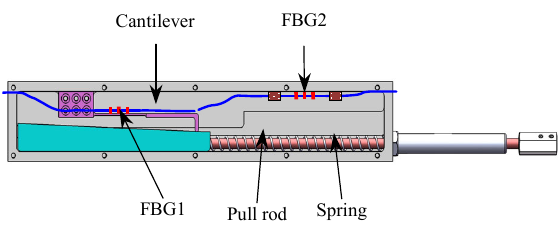
Fig. 6 Overall structure of an FBG displacement sensor.